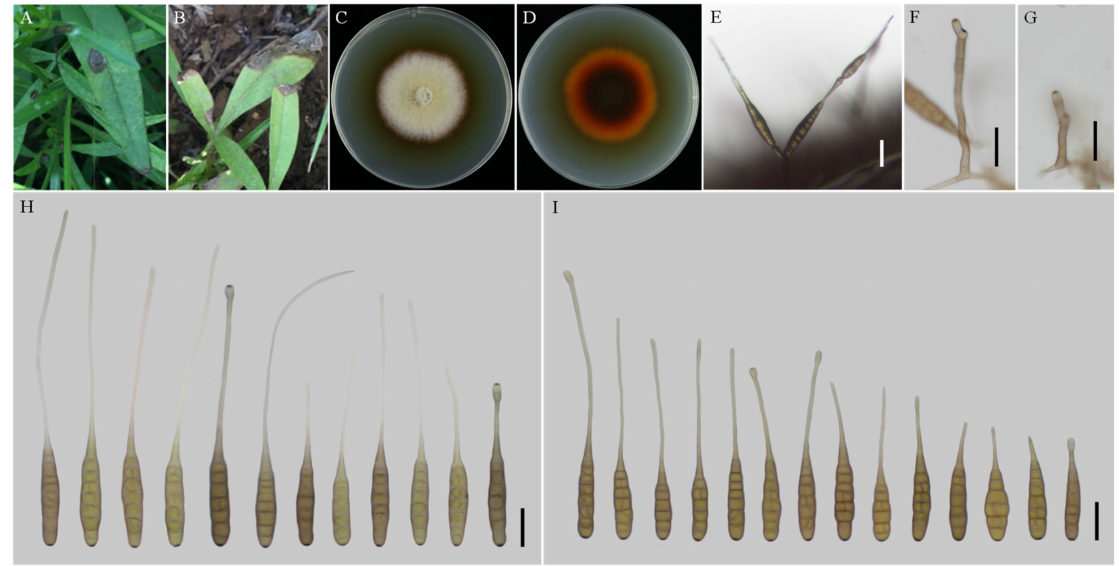
Figure 3. Morphology of Alternaria coreopsidis sp. nov. ( A , B ) Natural symptoms of Coreopsis basalis ; ( C , D ) Colony phenotypes (on PDA for 7 days at 25 ◦ C); ( E ) Sporulation patterns (on V8A at 22 ◦ C); ( F , G ) Conidiophores (on V8A at 22 ◦ C); ( H ) Conidia (on V8A at 22 ◦ C); ( I ) Conidia (on PCA at 22 ◦ C). Bars: ( E – I ) = 25 µ